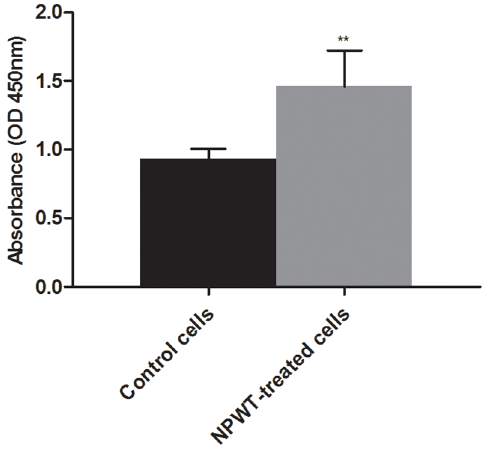
Figure 2. Cell proliferation assay. Following 72 hours of treatment with suction or static conditions, clots were exposed to water soluble tetrazolium salt-8-containing medium for 4 hours and optical density values at 450 nm were measured. Compared with control cells, NPWT- treated cells had a higher OD value (** p , 0.01).